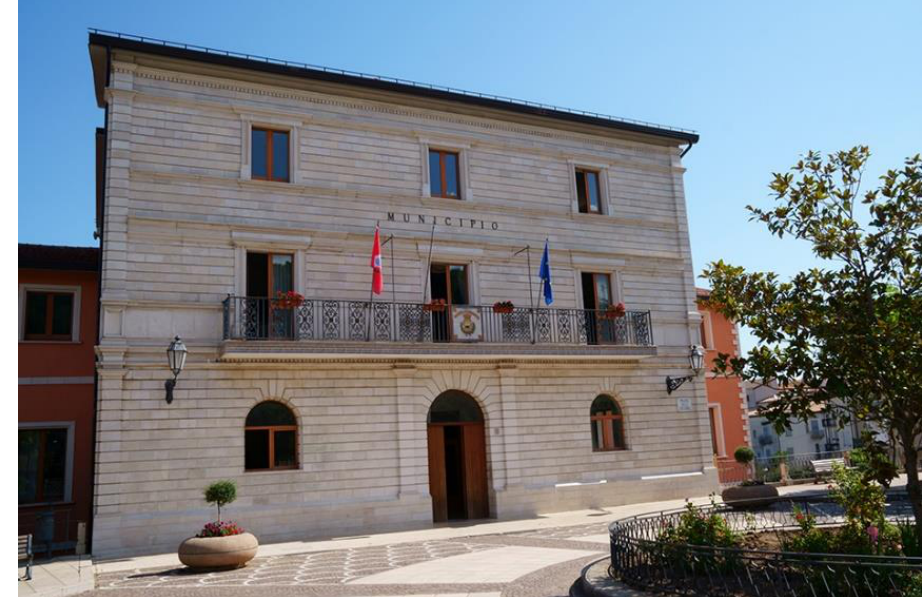
Geosciences 2021 , 11 , x FOR PEER REVIEW Figure 68. Pescopagano: the new Town Hall of village (photos by [35,36]). Figure 68. Pescopagano: the new Town Hall of village (photos by [35,36]).